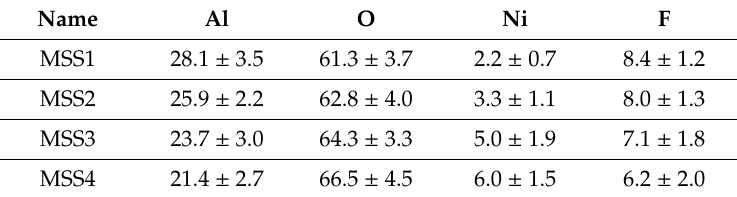
Table 3. Chemical composition (in at.%) of anodized aluminum alloy completely sealed in mixed solution analyzed by